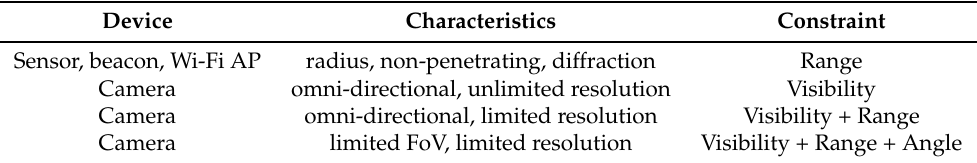
Table 2. Example constraints with respect to device characteristics.